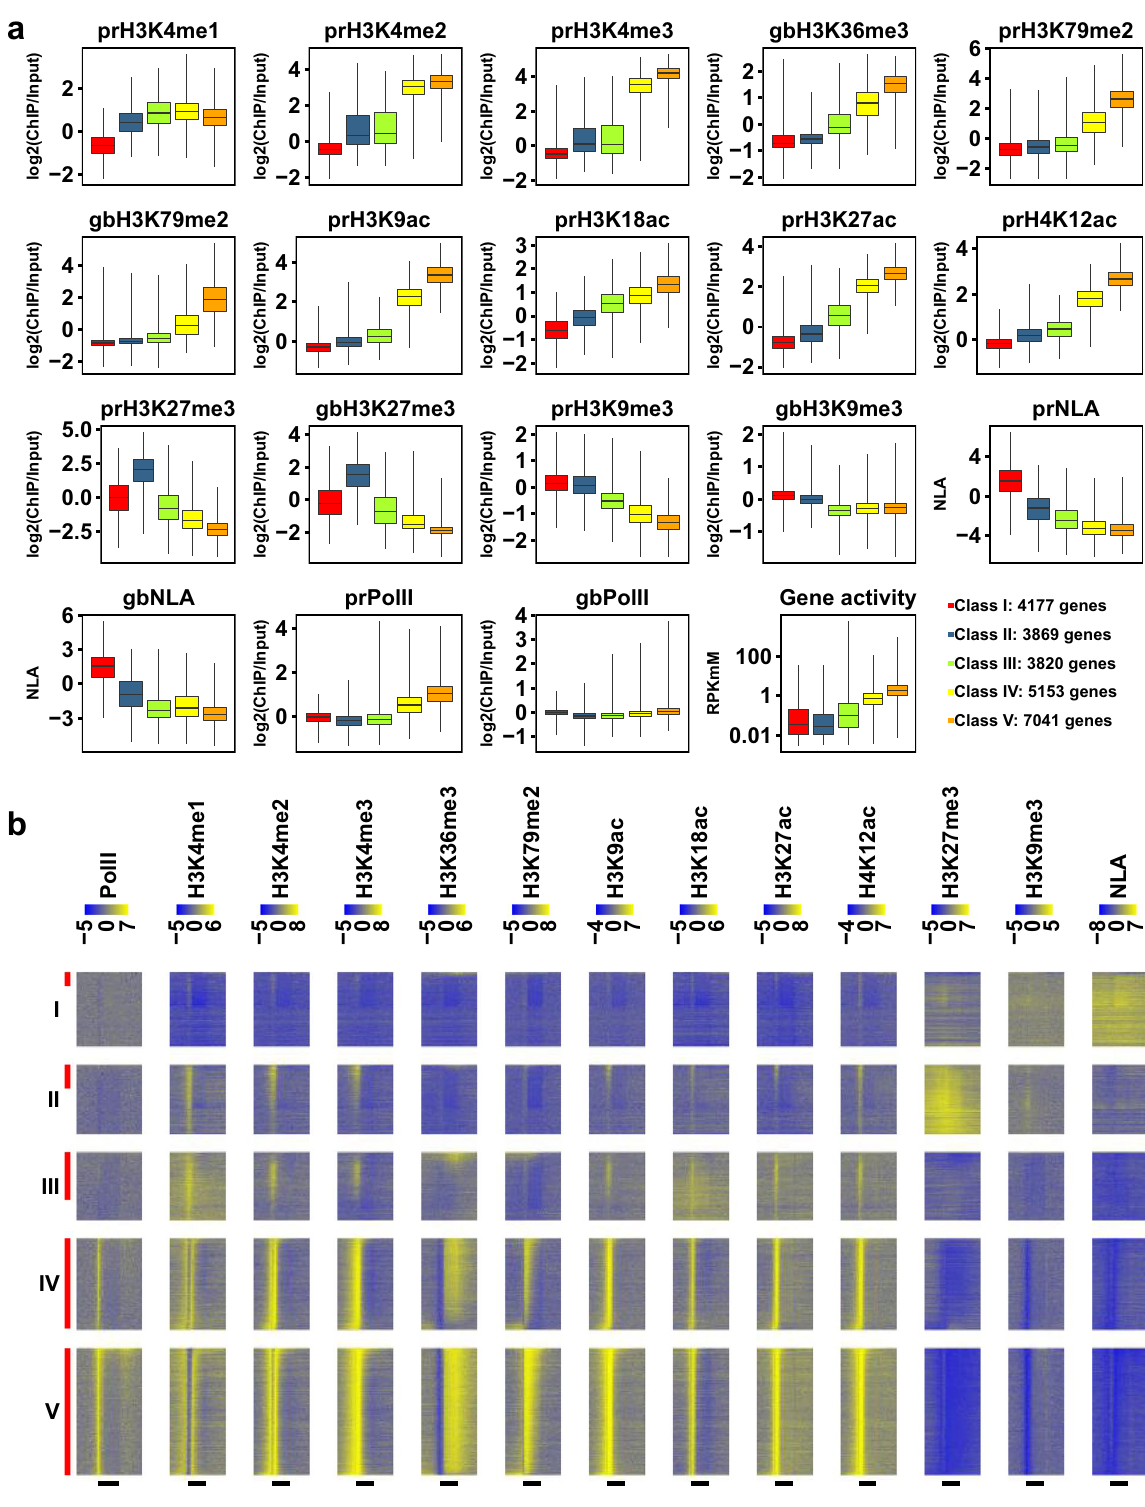
Figure 5. Five gene classes identified by clustering analysis exhibit distinct epigenetic features. ( a ) Box plots comparing levels of histone marks, NLA, and gene activity among the five gene classes in C2C12 myoblasts. “pr” and “gb” represent promoter regions and gene bodies, respectively. The minimum and the maximum values are presented by whisker ends and quartiles by box boundaries. For all variables, Mann-Whitney tests revealed significant differences (FDRs < 0.05) between every pair of the five classes. ( b ) Heat maps of Pol II, histone marks and NLA across genic regions. Genes in each class are sorted by decreasing gene activity. Vertical red bars on the left mark active genes (18.58%, 33.95%, 69.88%, 98.50% and 99.97% of Class I to V, respectively). Horizontal black bars at the bottom mark annotate transcribed regions from TSS to TES. Data are binned as described in Fig.